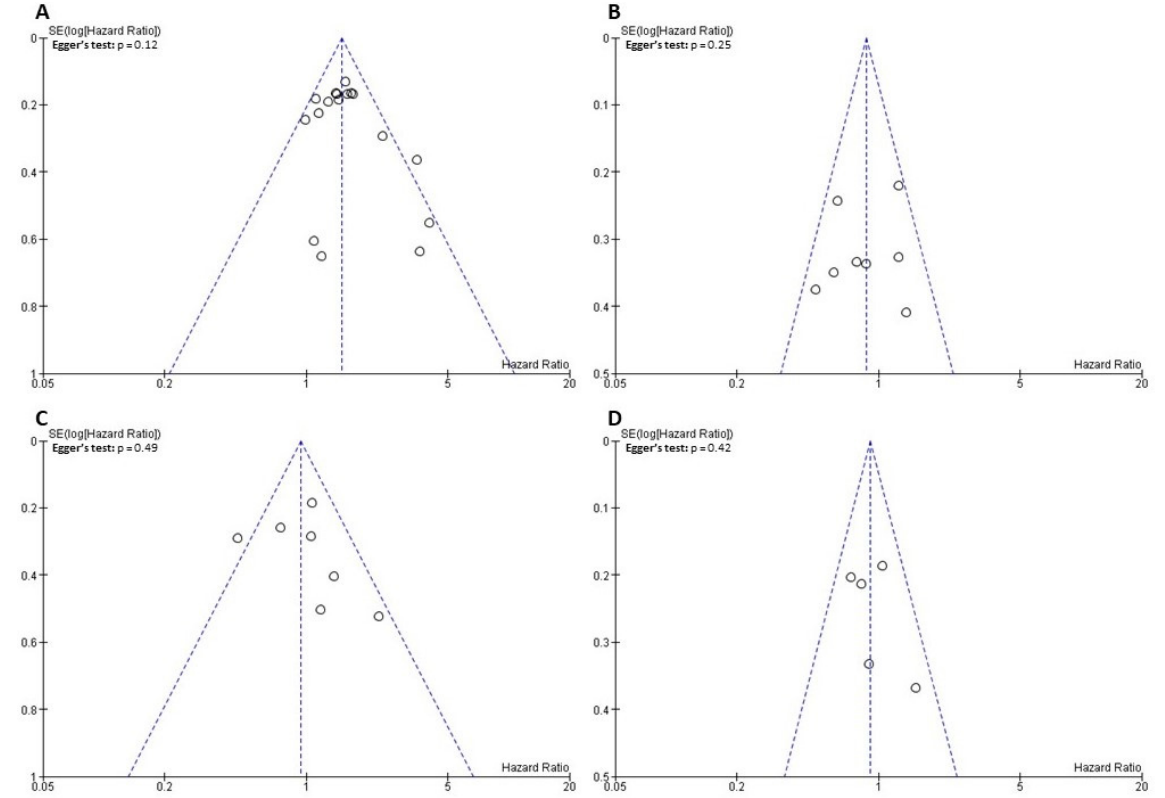
Figure 7. Funnel plot for the evaluation of potential publication bias: ( A ) intravesical recurrence-free survival; ( B ) cancer- specific survival; ( C) overall survival; ( D ) metastasis-free survival. SE = standard error.